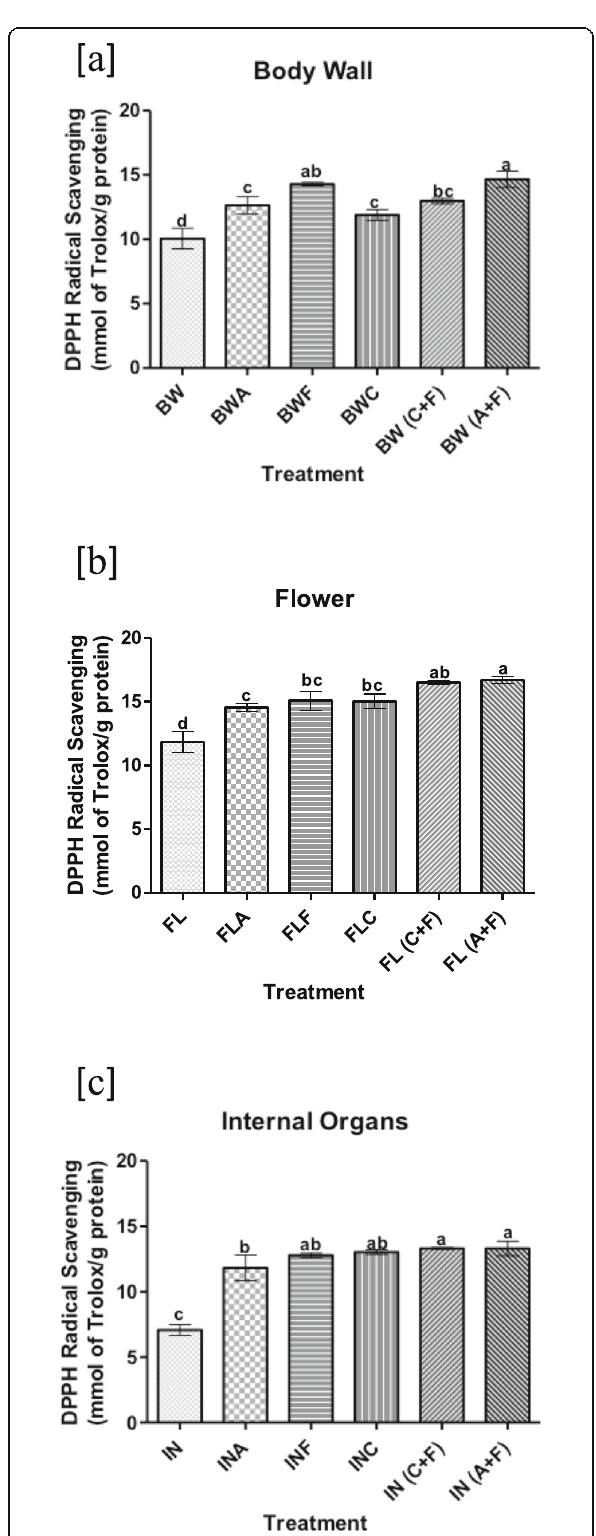
Fig. 4 DPPH radical scavenging activity of sea cucumber C. frondosa protein hydrolysates a BW, Body wall; b FL, Flower; and c IN, Internal organs; A, Alcalase; F, Flavourzyme; C, Corolase; C + F, Mixture of Corolase and Flavourzyme; and A + F, Mixture of Alcalase and Flavourzyme. Different letters for the same concentration of all hydrolysates indicates significant difference at p <